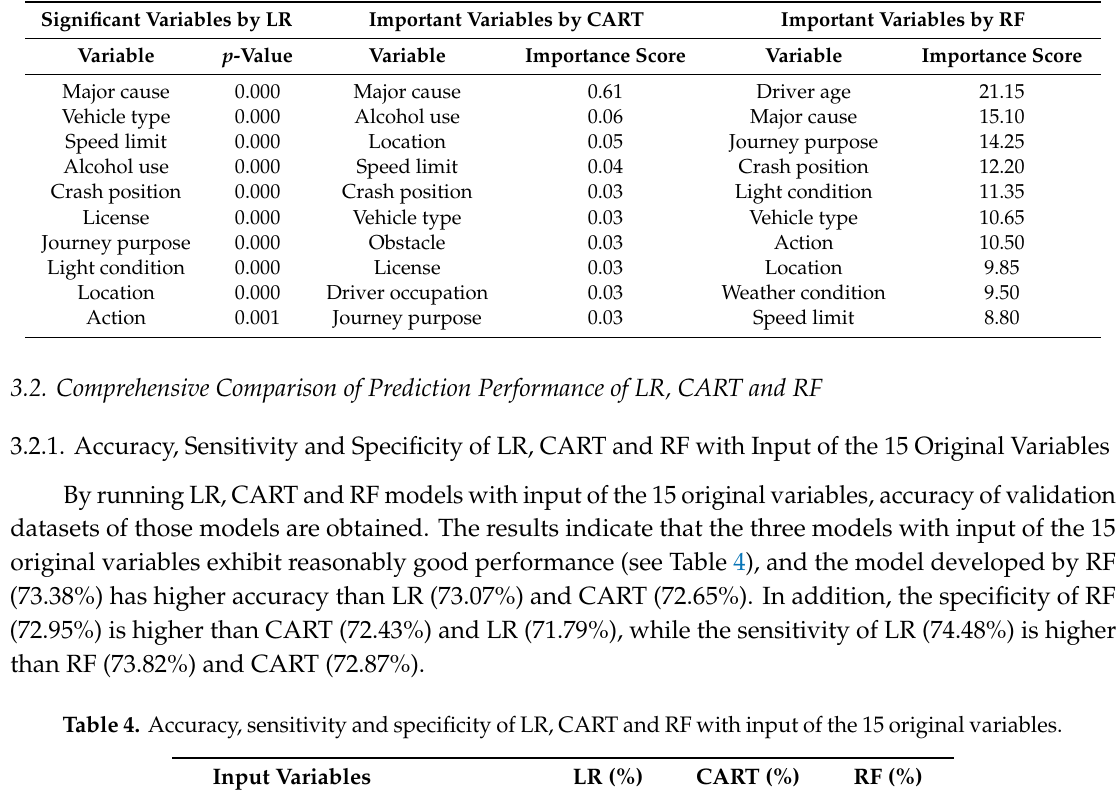
Table 4. Accuracy, sensitivity and specificity of LR, CART and RF with input of the 15 original variables.